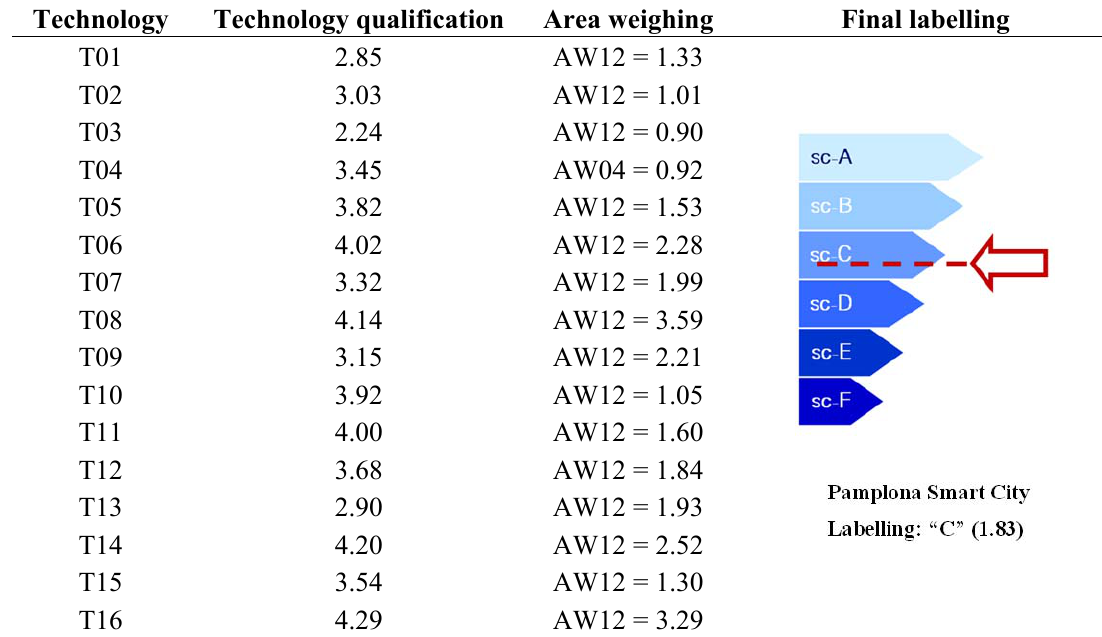
Table 5. SCM for Pamplona City strategy.